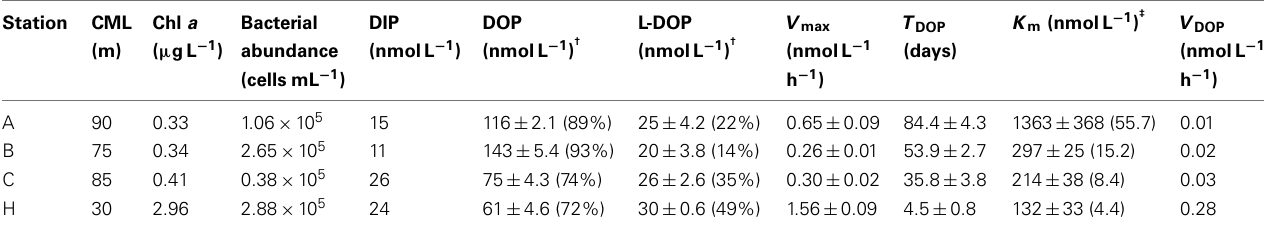
Table 1 | Depth of CML, Chl a concentration, bacterial cell abundance, concentrations of P pools, andAPA kinetic parameters at the CML at three offshore stations and one coastal station in the western North Pacific